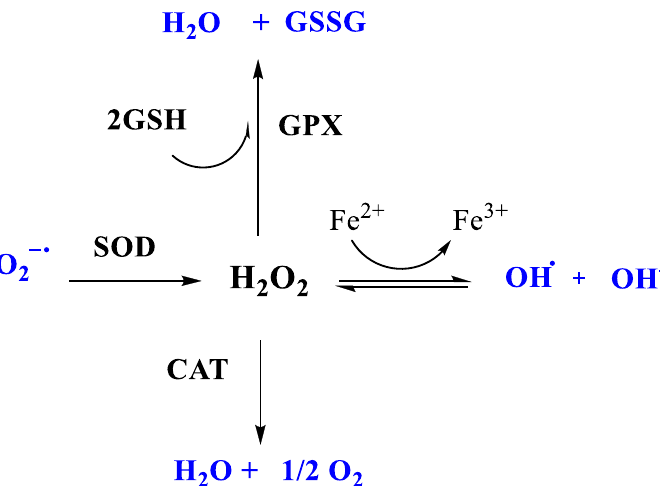
Scheme 2. Main enzymes involved in enzymatic antioxidant system